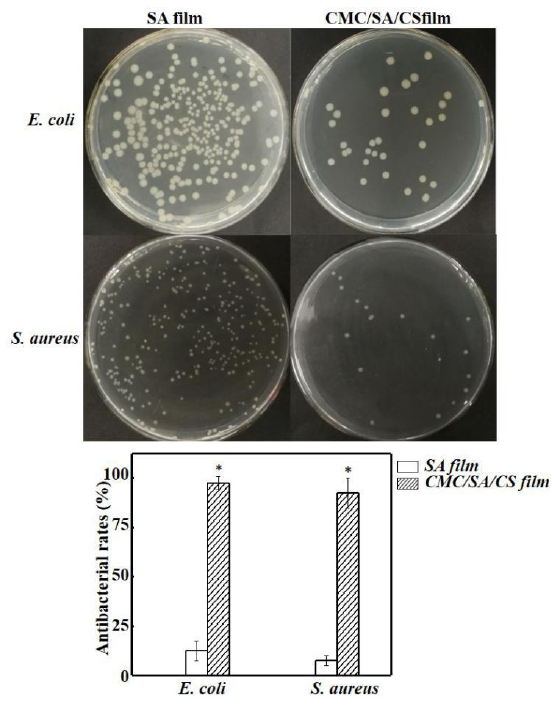
Figure 3. The antibacterial performance of the composite film against E. coli and S. aureus . (* p < 0.05).